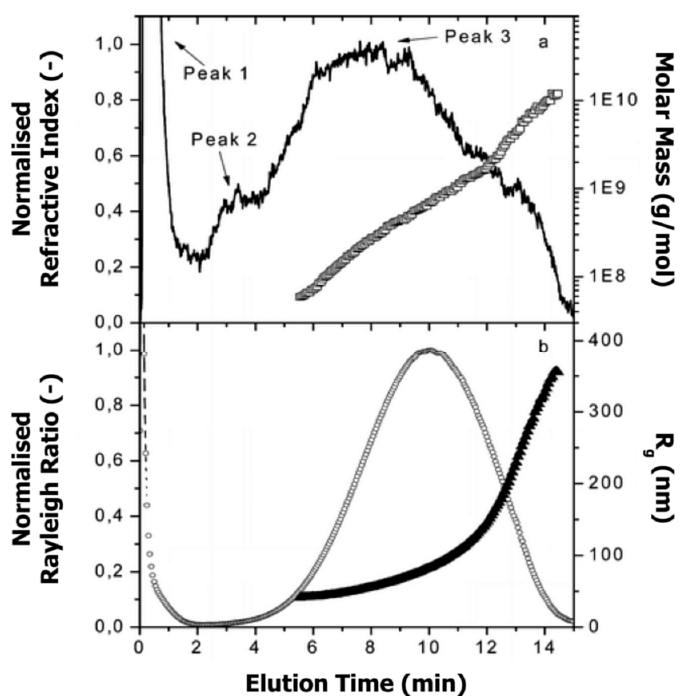
Figure 14. ( a ) Molar mass ( □ ) and normalised refractive index signal (-) vs. elution time, and ( b ) radius of gyration ( R g ; ▲ ) and normalised Rayleigh ratio (90° scattering angle; ◌ ) vs. elution time for casein micelles in milk. Reproduced with permission from [188]. Copyright by American Chemical Society, 2000.